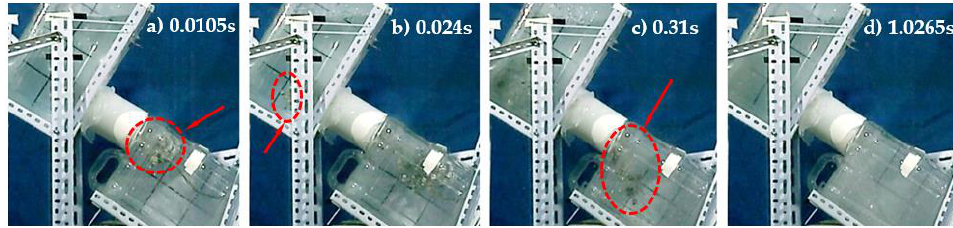
Figure 6. Process for experimental case 2 (β = 30°, h = 205 mm).